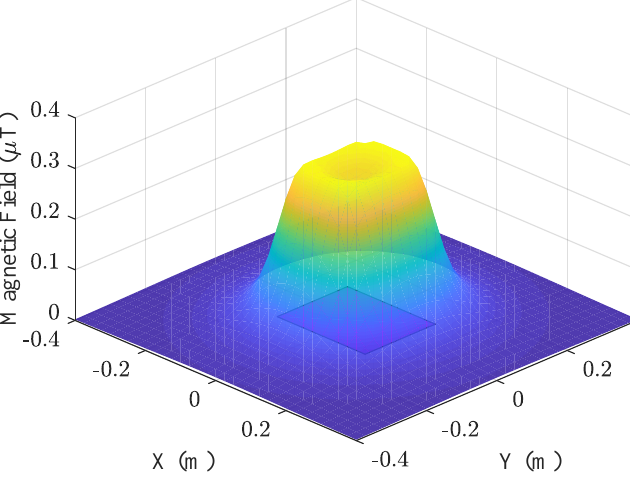
Figure 2. | B | in an area of 0.4 × 0.4 m at a height of z = 0.05 m. The magnetic field generated by the current that circulates in a conductor (transmitter coil) can be induced to another conductor (receiver coil) that will in turn generate elec- tric